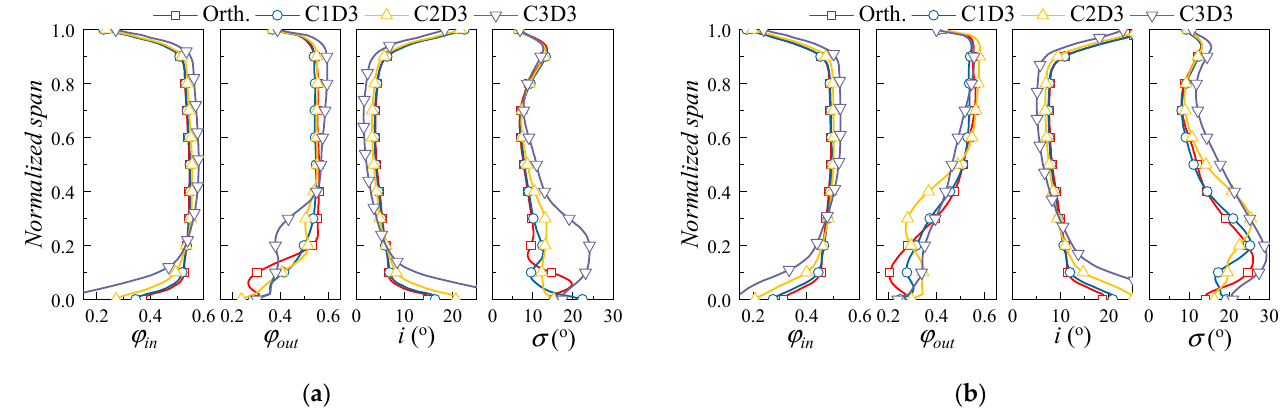
Figure 17. Radial distribution of aerodynamic performances for the cases with different dihedral heights. ( a ) φ = 0.52; ( b ) φ = 0.46.